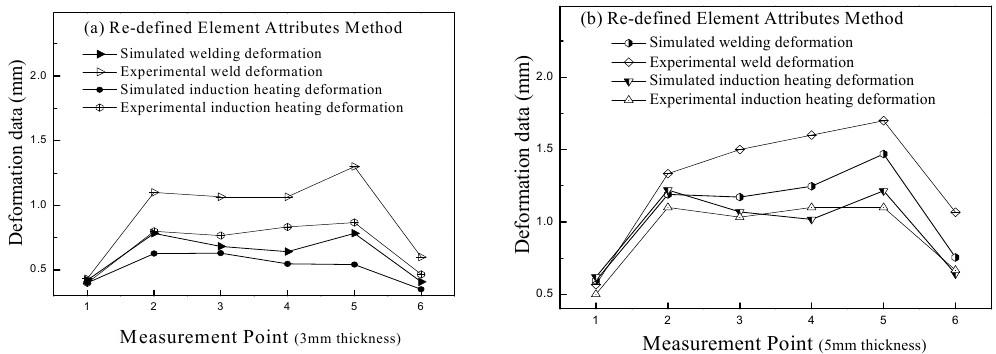
Figure 16. Comparison of longitudinal residual stress between re-defined element attributes method and experiment. ( a ) 3 mm, ( b ) 5 mm.